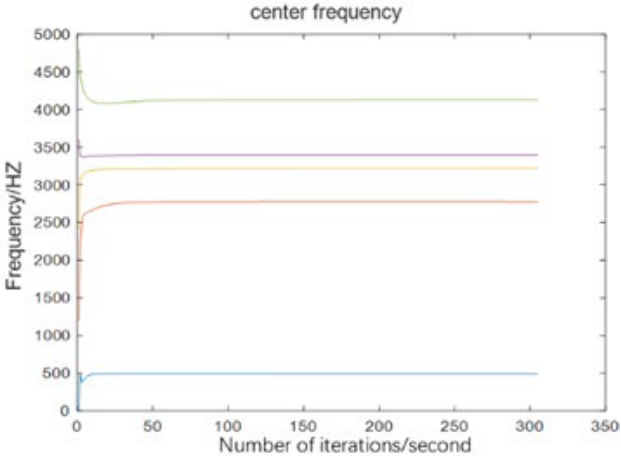
Figure 2. Center frequency of the modal component K = 5.